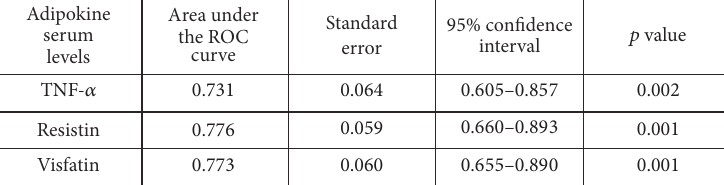
Figure 2: Comparison of receiver operating characteristic (ROC) curves for TNF- 𝛼 , resistin, and visfatin in autistic and healthy